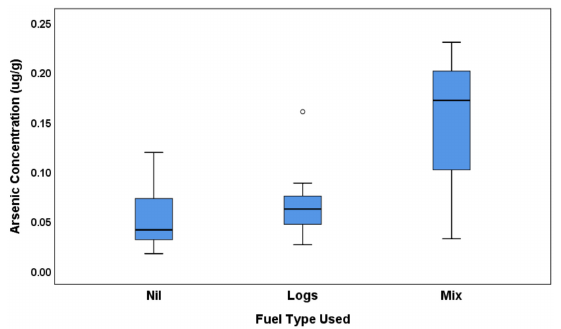
Figure 3. Average arsenic concentrations as a function of the fuel type